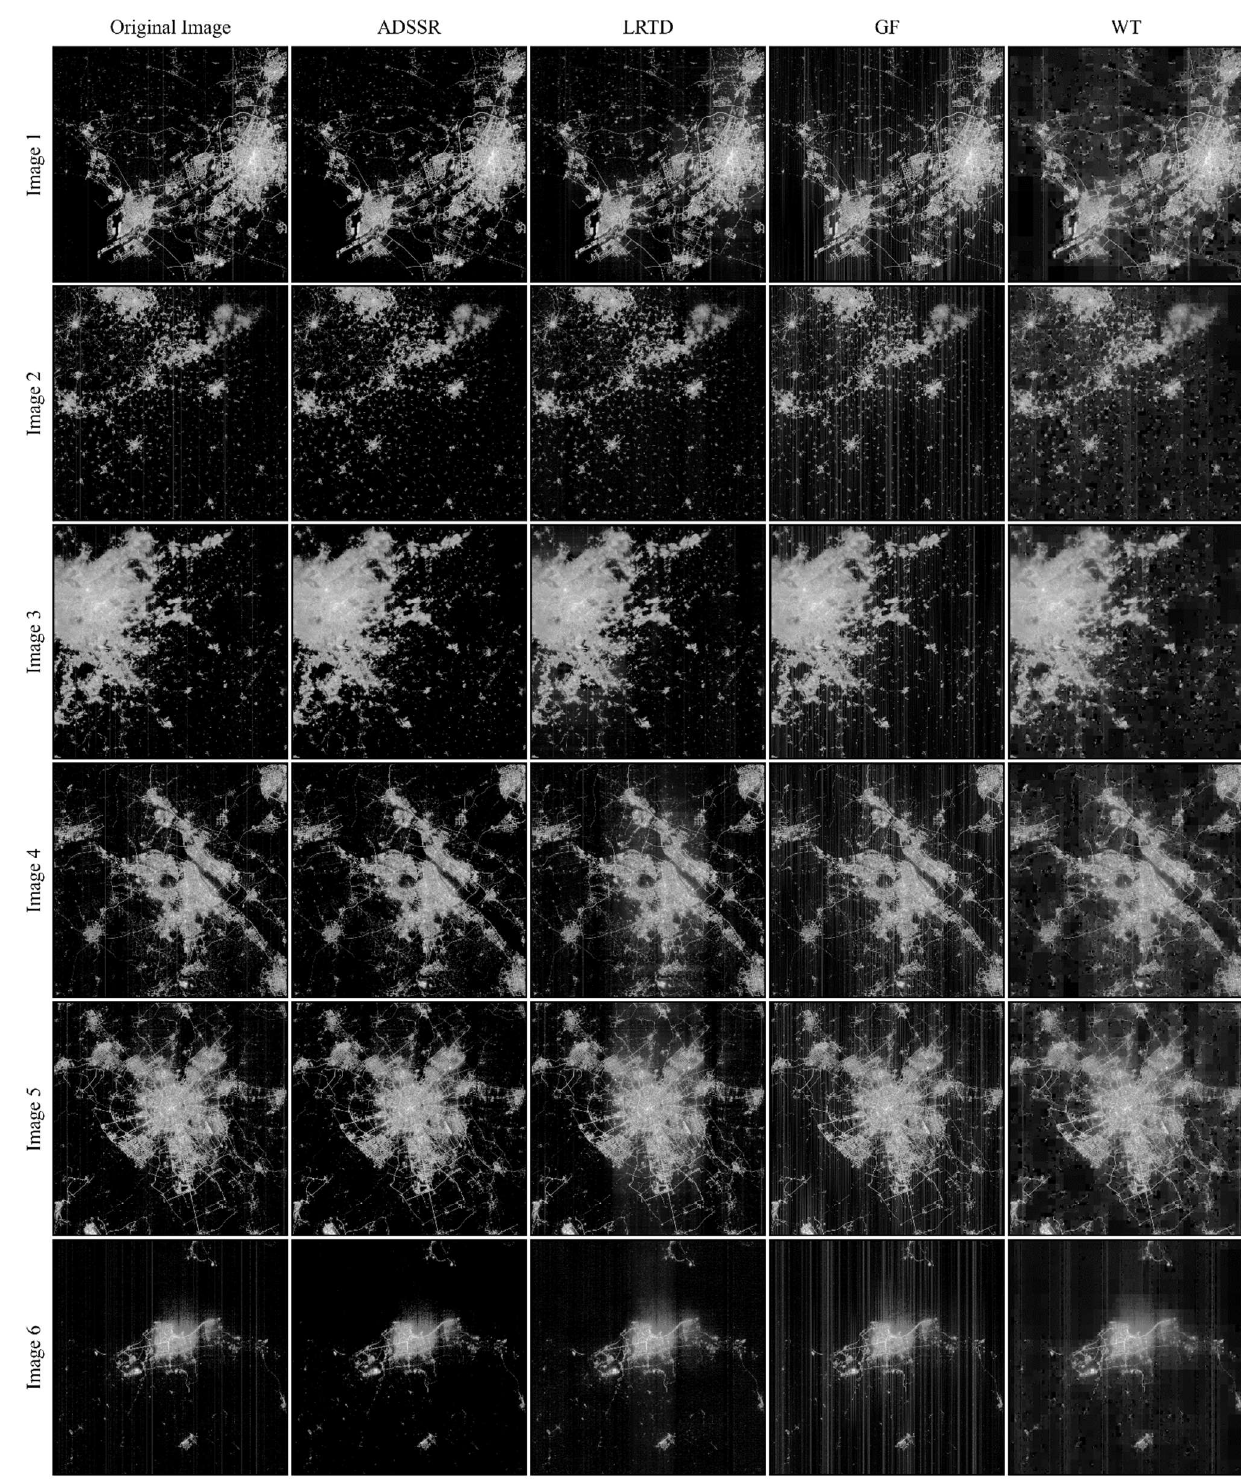
Figure 10. Destriping results of six test images.